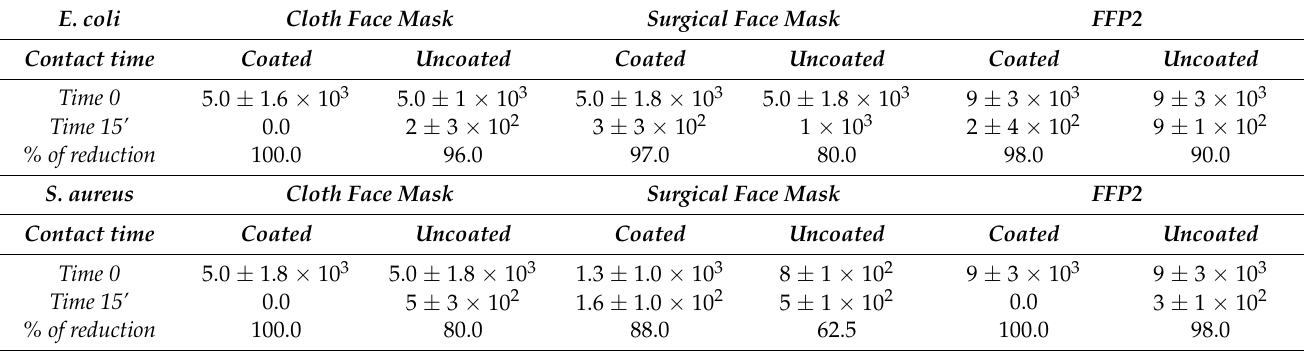
Table 1. Overview of the antimicrobial activity. Exposure at T 0 and T 15 for TiO 2 microparticle film in cloth face masks, surgical face masks, and FFP2 masks after exposition to blue light. TiO 2 treated and untreated masks were contaminated with E. coli and S. aureus